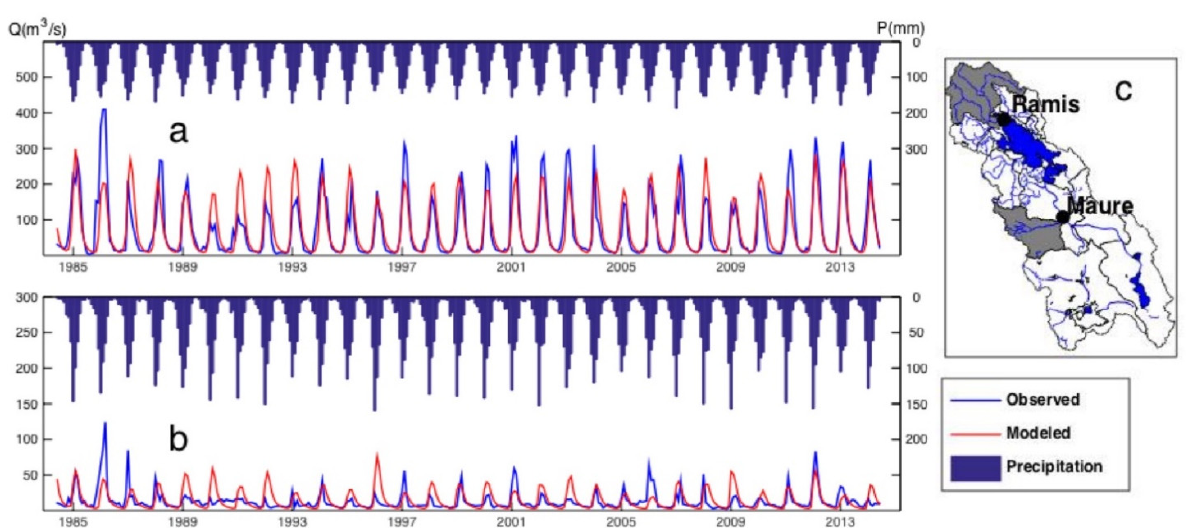
Figure 6. Observed and modeled streamflow hydrographs between 1984 and 2014 at ( a ) Ramis and ( b ) Calacoto Maure stations. ( c ) Location of Ramis and Maure river sub-basins controlled at the Ramis and Maure stations are indicated on the map.